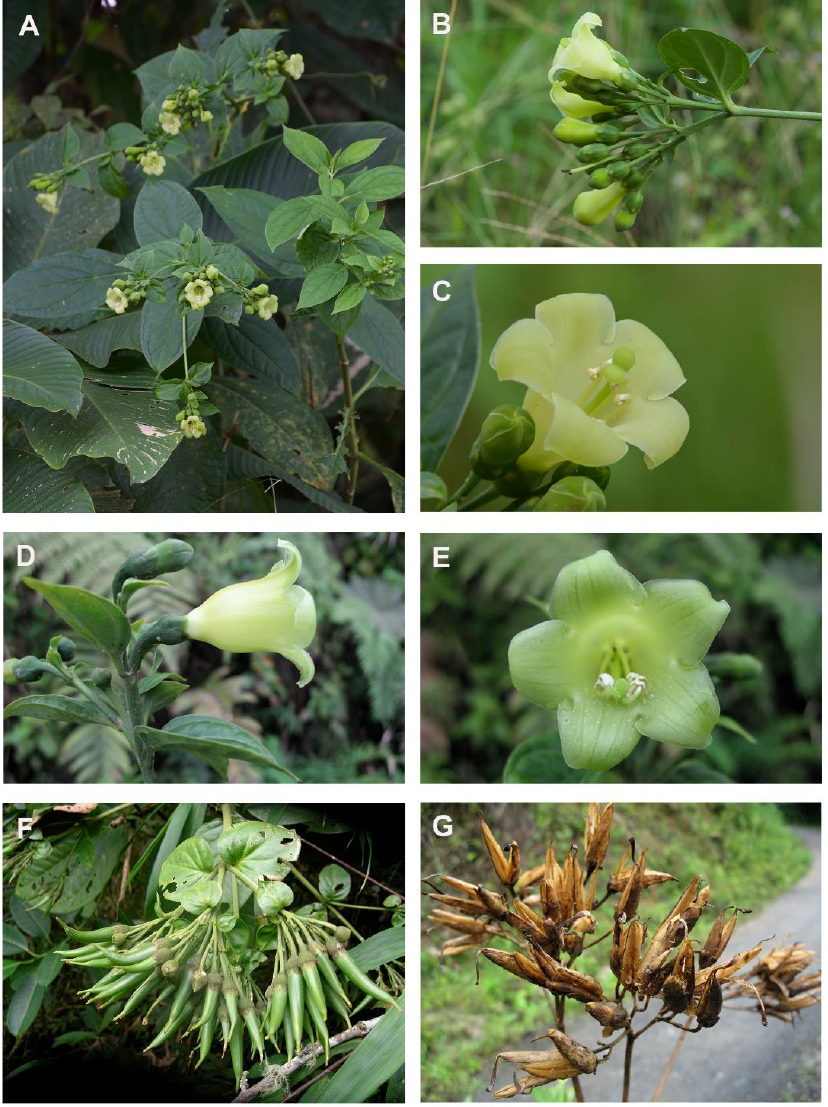
Figure 5. Morphological diversity in Macrocarpaea (Gentianaceae). ( A – C ) M. cortinae J.R. Grant; ( D , E )